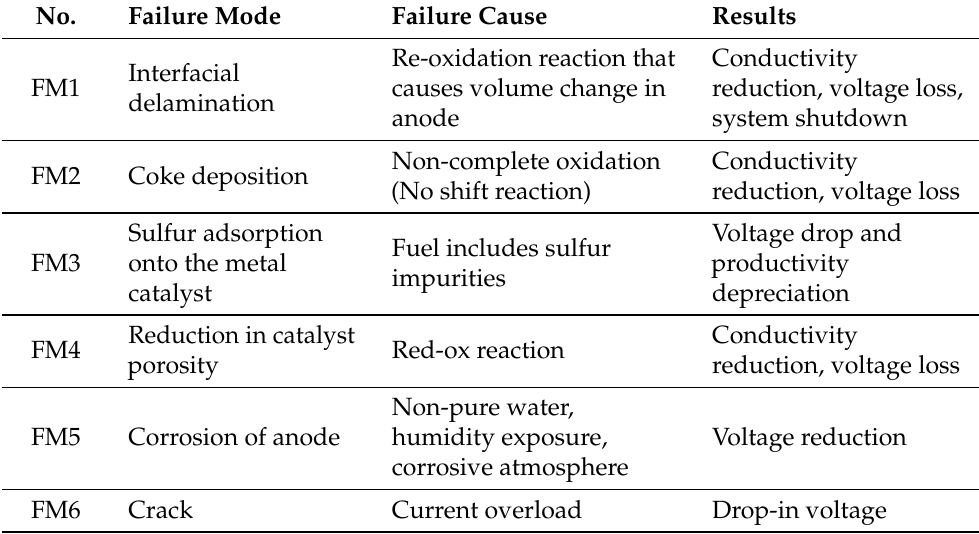
Table 6. Failure modes, causes, and effects.